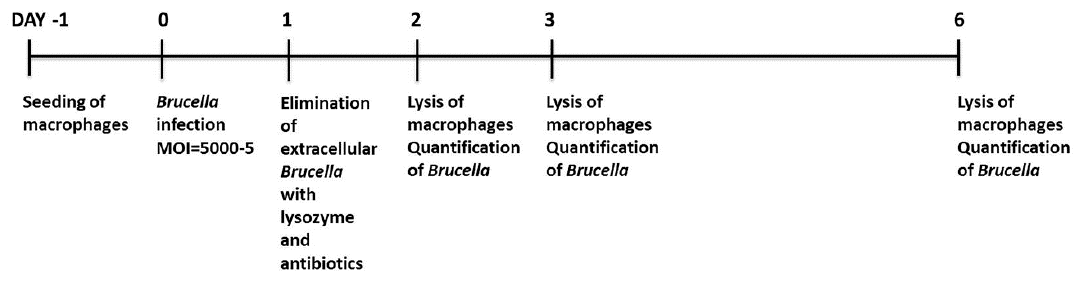
Figure 1. Schematic diagram and timeline of the study.